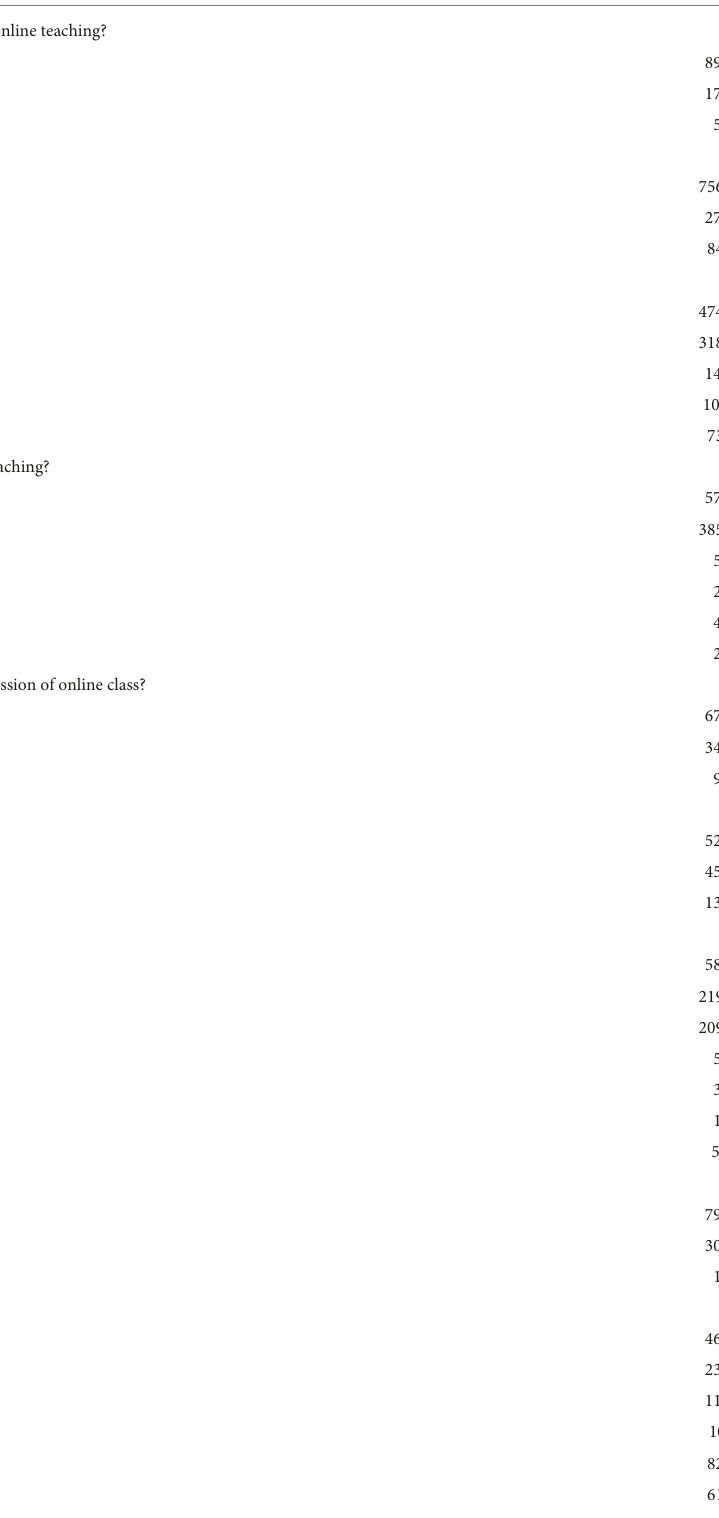
TABLE 3 Current practices and tools of online teaching during COVID-19.